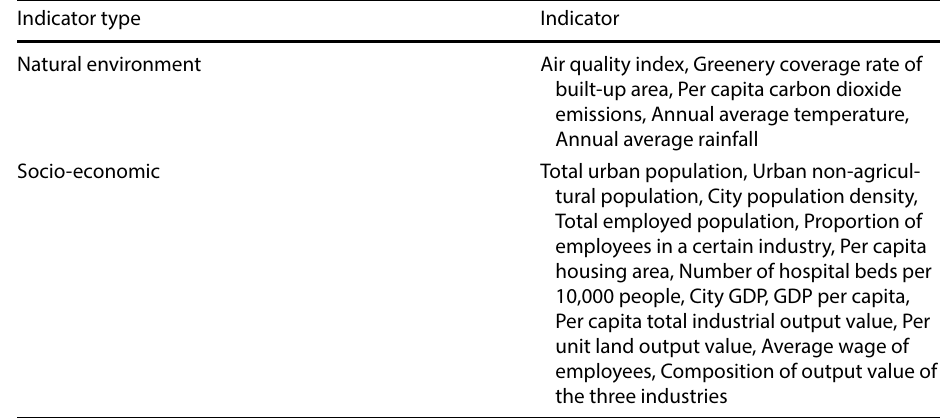
Table 2 Indicators that can be used for city-type identification